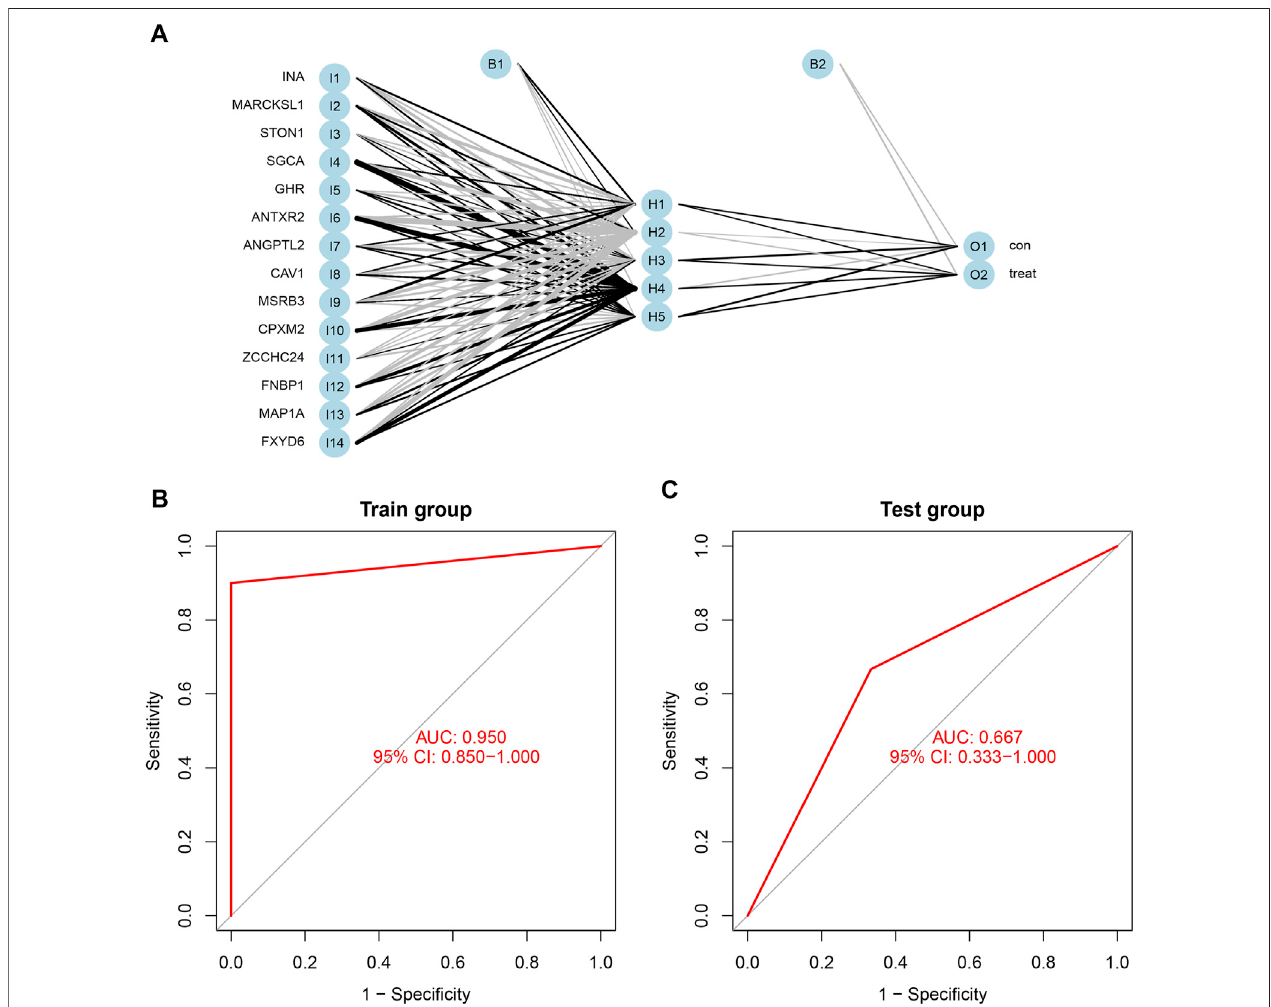
FIGURE 7 | (A) The neural network model included three layers: input layer, hidden layer, and output layer. the scores and weights of feature genes. (B) The ROC curve of the train group including GSE61615 and GSE65635; the AUC was 0.950 (95% CI: 0.850 – 1.000). (C) The ROC curve of the test group including GSE100926; the AUC was 0.667 (95% CI: 0.667 –